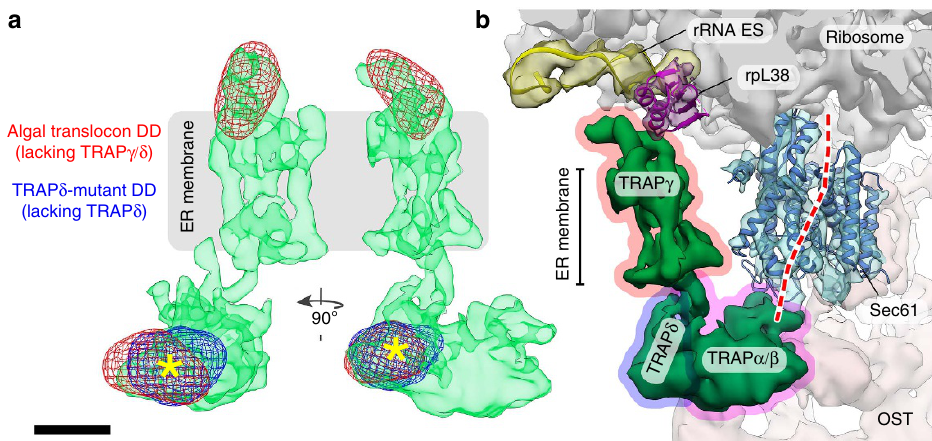
Figure 5 | Dissecting the molecular organization of the TRAP complex. ( a ) Set of difference densities (DD) originating from the TRAP d -deficient fibroblast translocon (blue mesh) and the algal translocon (red mesh) mapped back on the isolated density of the TRAP complex from EMD-3068 (green). For the lumenal TRAP segment, difference densities originating from the TRAP d -deficient fibroblast translocon and the algal translocon co-localize (asterisks). Scale bar, 2nm. ( b ) Approximate positions of TRAP g (red outline), TRAP d (blue outline) and the TRAP a – b heterodimer (magenta outline), assigned according to the set of difference densities in a . The path of a nascent protein through the Sec61 complex (dashed red line) was traced based on PDB 5EUL. View and colouring matches Fig.